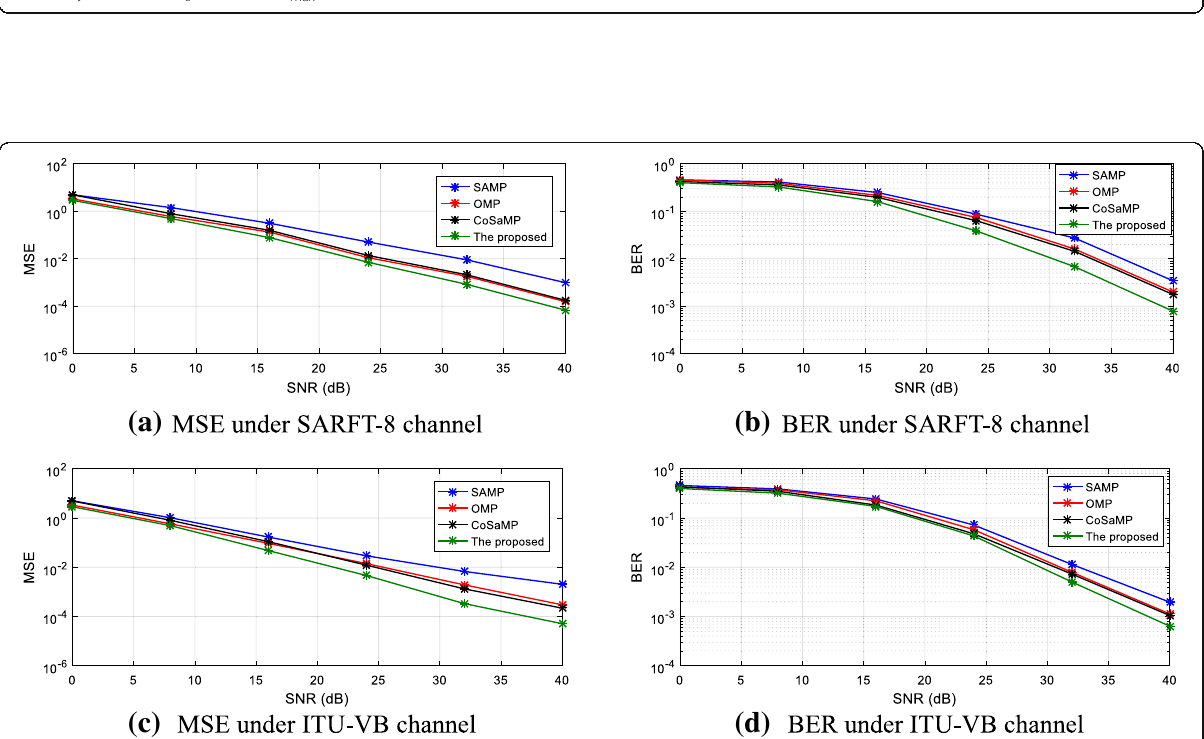
Fig. 8 The MSE and BER performance of the proposed PCS-information-based CS channel estimation scheme in 8 × 8,16 × 16, and 32 × 32 MIMO- OFDM systems with f c = 0.05 and f max = 20 HZ